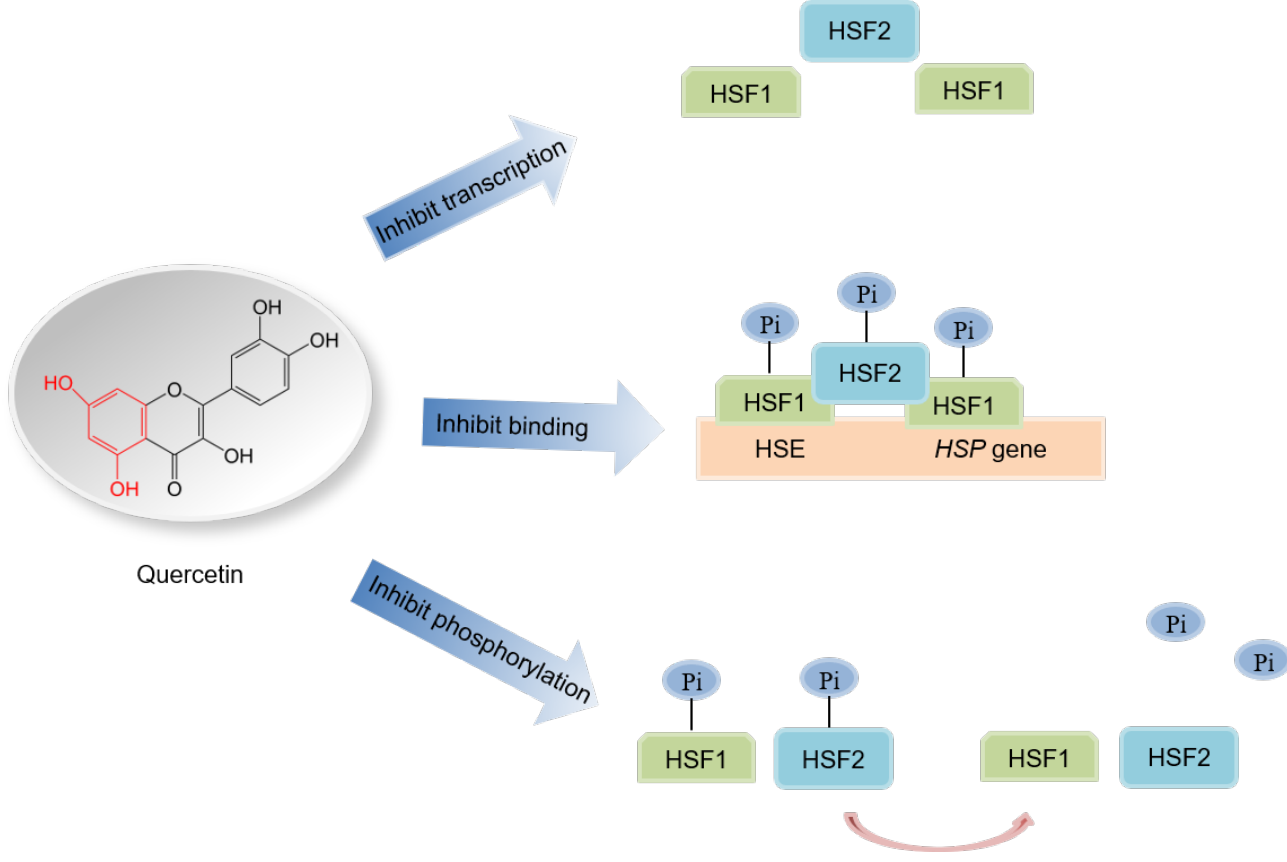
Figure 6. The action mechanism of HSP regulation by quercetin. Abbreviations: HSP, heat shock protein; HSF, heat shock factor; HSE, heat shock element.